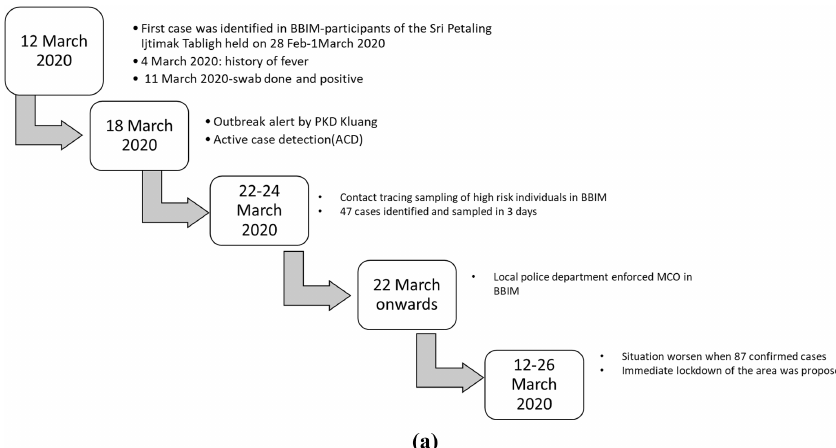
Figure 1. Chronology of